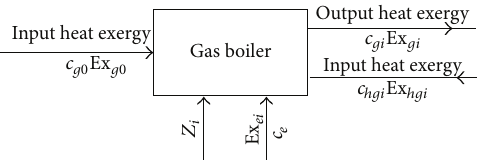
Figure 6: The thermoeconomics model of the gas boiler heating